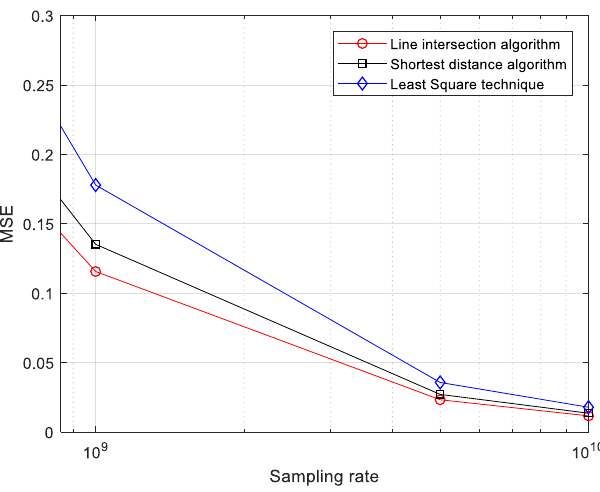
Figure 14. The enlarged MSEs of the MS position estimation for the third case.